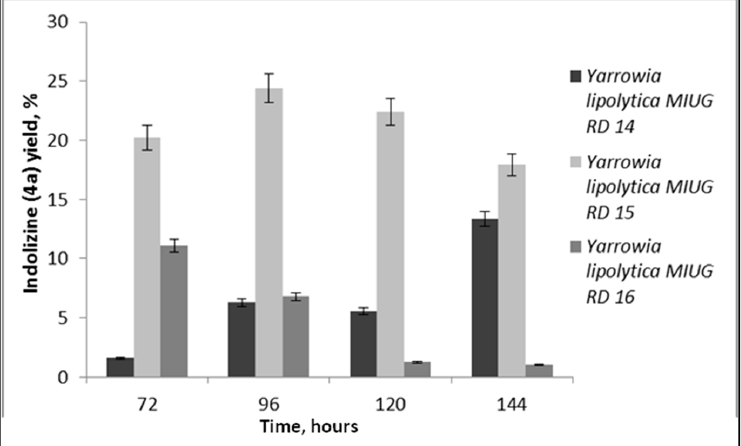
Figure 6. Yield of indolizine 4a, obtained using Yarrowia lipolyti ca biomass as biocatalysts.